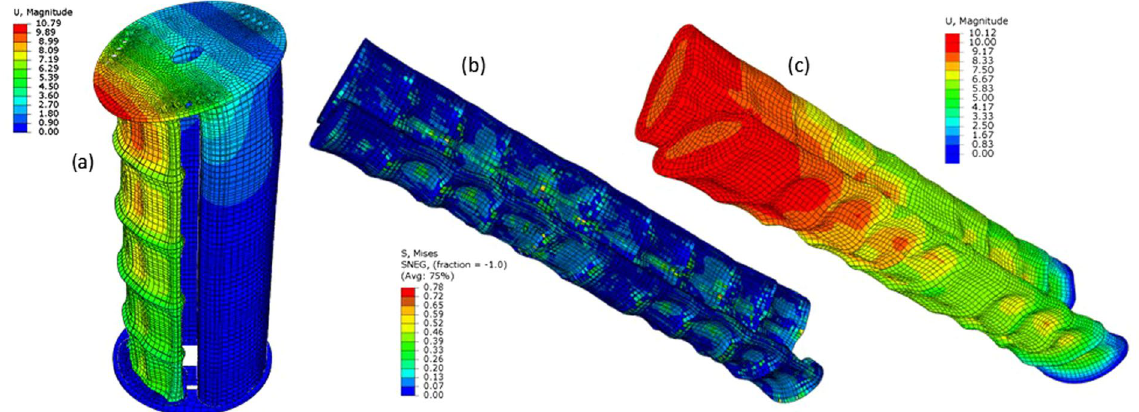
Figure 5. (a) Simulation result for a three column V-SPA module assembly in free displacement condition. The bottom plate is kept fixed. (b) Simulation result for a two column wearable V-SPA assembly made of the same structural units (comprising the foam core and Elastosil skin) as the three column assembly, in blocked ends condition, and under a distributed pressure loading scheme. The stresses generated in the assembly are closely representative of the stresses generated in the spinal column under high compression loading. (c) Displacement profile for the device under the same conditions as in ( b ).